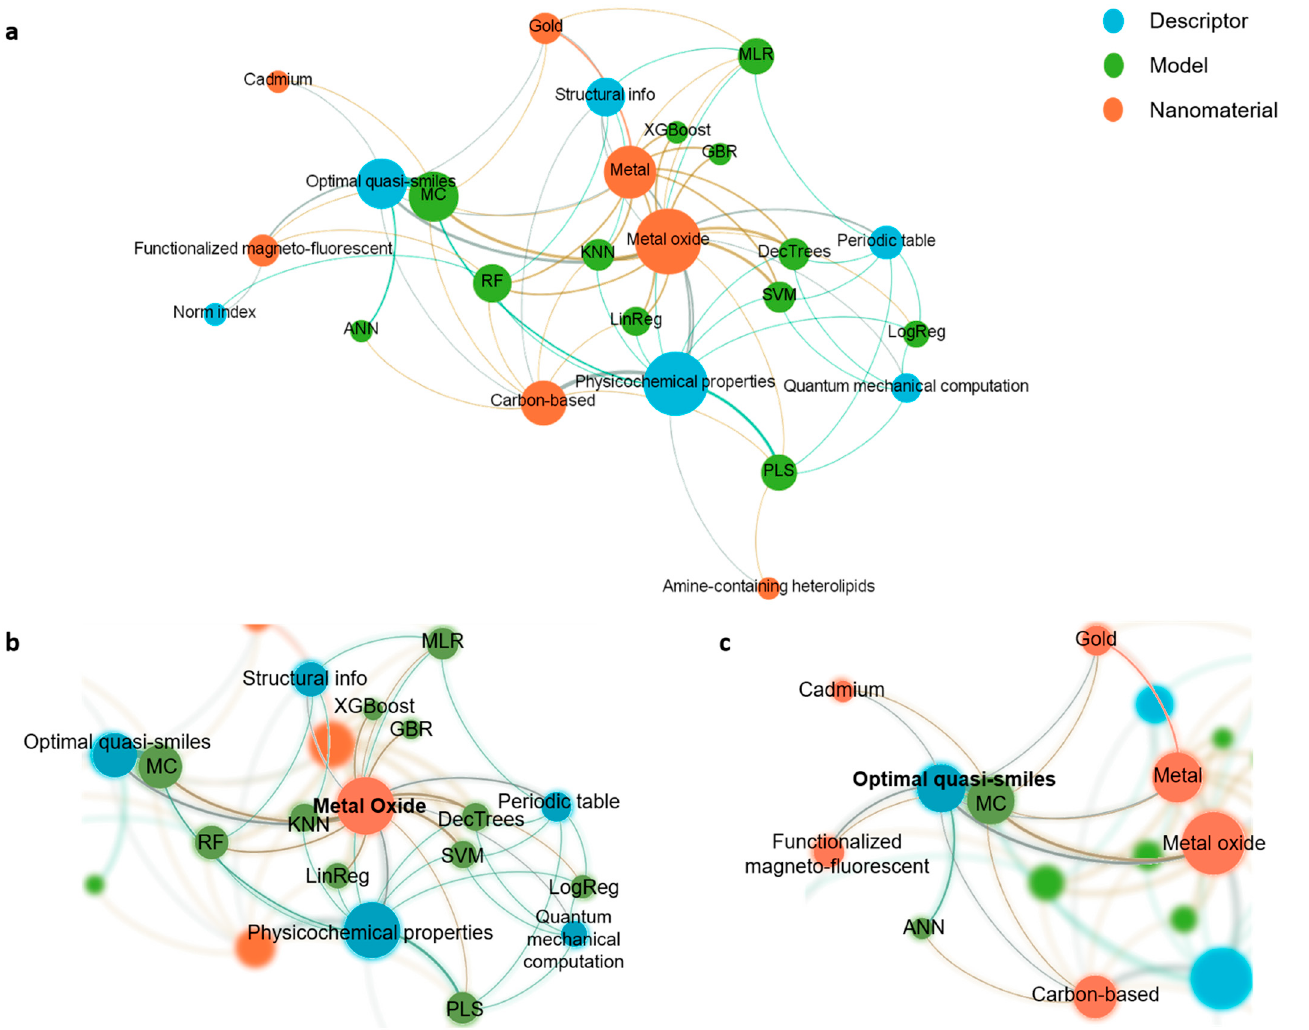
Figure 7. Graphical network of the 19 articles that meet the criteria to be included in Table 1. ( a ) Network with all the connections between the types of nanomaterials, their relevant structural characteristics (descriptors), and the QSAR models used to predict a defined endpoint. ( b ) Most relevant connections of metal oxide class. ( c ) Most relevant connections of optimal quasi-SMILES- based descriptors and the closely related Monte Carlo (MC) algorithm. ANN: artificial neural network; DecTrees: decision trees; GBR: gradient boosting regressor; KNN: k ‐ nearest neighbors; LinReg: linear regression; LogReg: logistic regression; MC: Monte Carlo; MLR: multiple linear regression; PLS: partial least squares; RF: random forest; SVM: support vector machine; XGBoost: extreme gradient boosting.